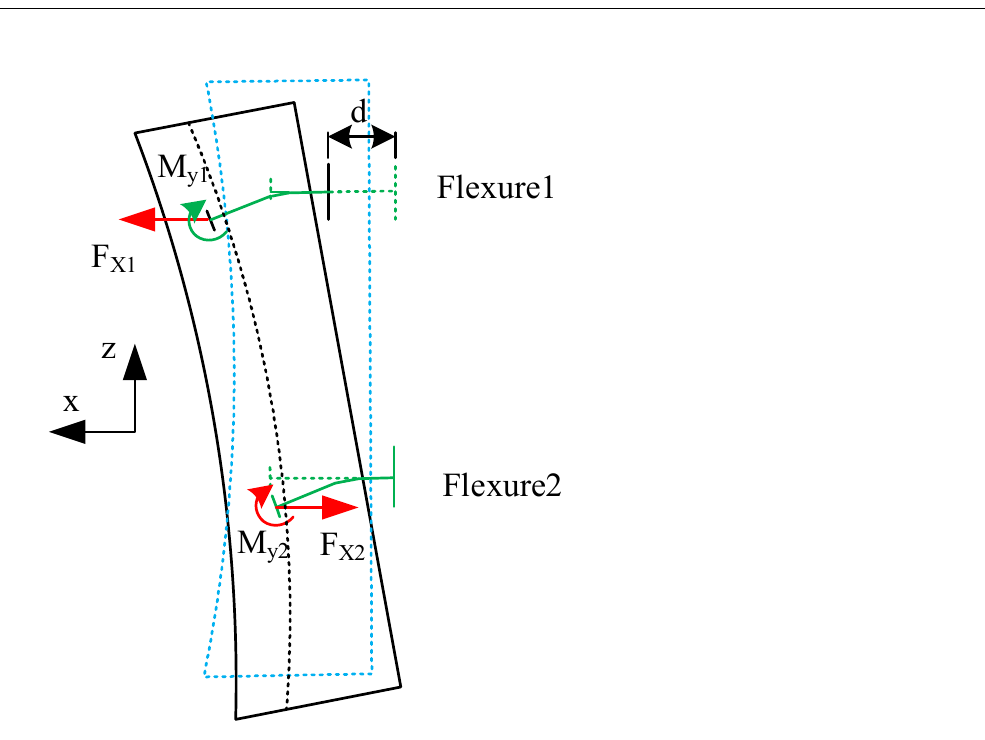
Figure 1. Schematic distribution of the transmitted loads under flatness error. For the present study, a lightweight SiC mirror assembly adopting three-point sup- ports is designed. According to the optical error analysis, the required comprehensive surface accuracy should not exceed 5.6 nm. Then, 5.6 nm is decomposed into 2.5 nm for gravity; The surface distortion caused by the assembly error is less than 3.5 nm, which mainly refers to the surface distortions induced by 0.08 mm flatness error of the mounting face, and The deviation between the axial installation position and the ideal position of the flexible joint is caused by manufacturing and assembly errors, which leads to the degrada- tion of the mirror shape accuracy less than 2.5 nm.; When the temperature change is 4 ◦ C, the allowed degradation of surface accuracy is 2.5 nm, as shown in Figure 2 [15].